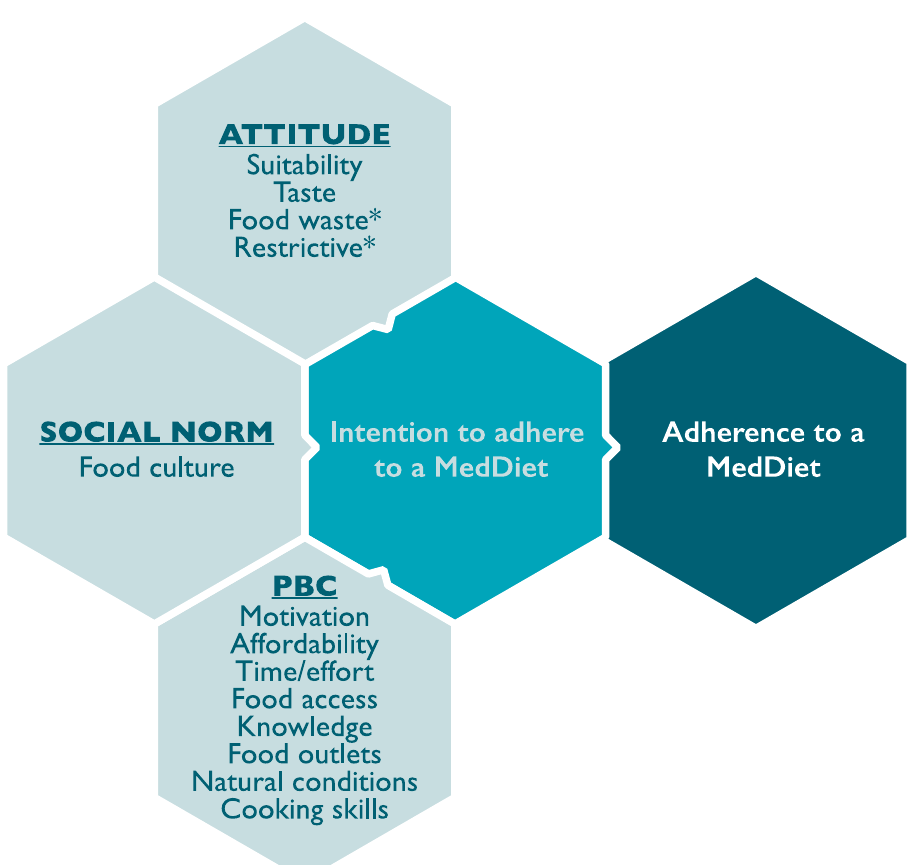
Figure 2. A model outlining the perceived barriers and enablers toward adherence to a MedDiet in Australian adults (model adapted from Ajzen’s Theory of Planned Behaviour [26]). Abbreviations: PBC, perceived behavioural control; * Is exclusively a perceived barrier.